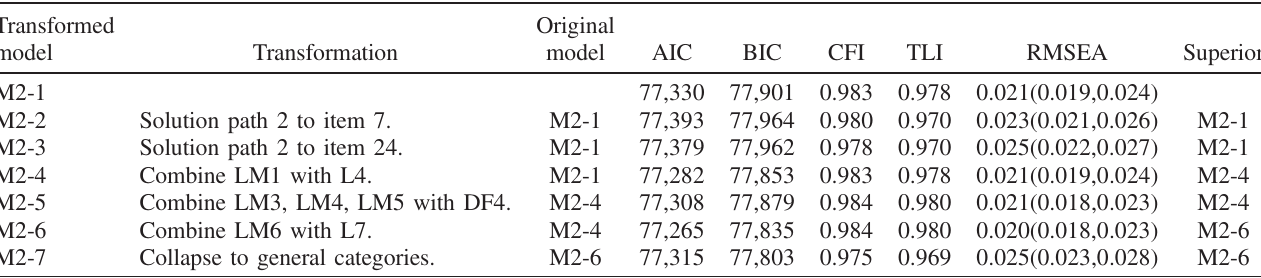
TABLE III. Sample 2 model transformation. Differences in AIC and BIC determine whether the models are statistically different; CFI, TLI, and RMSEA indicate the quality of fit for each